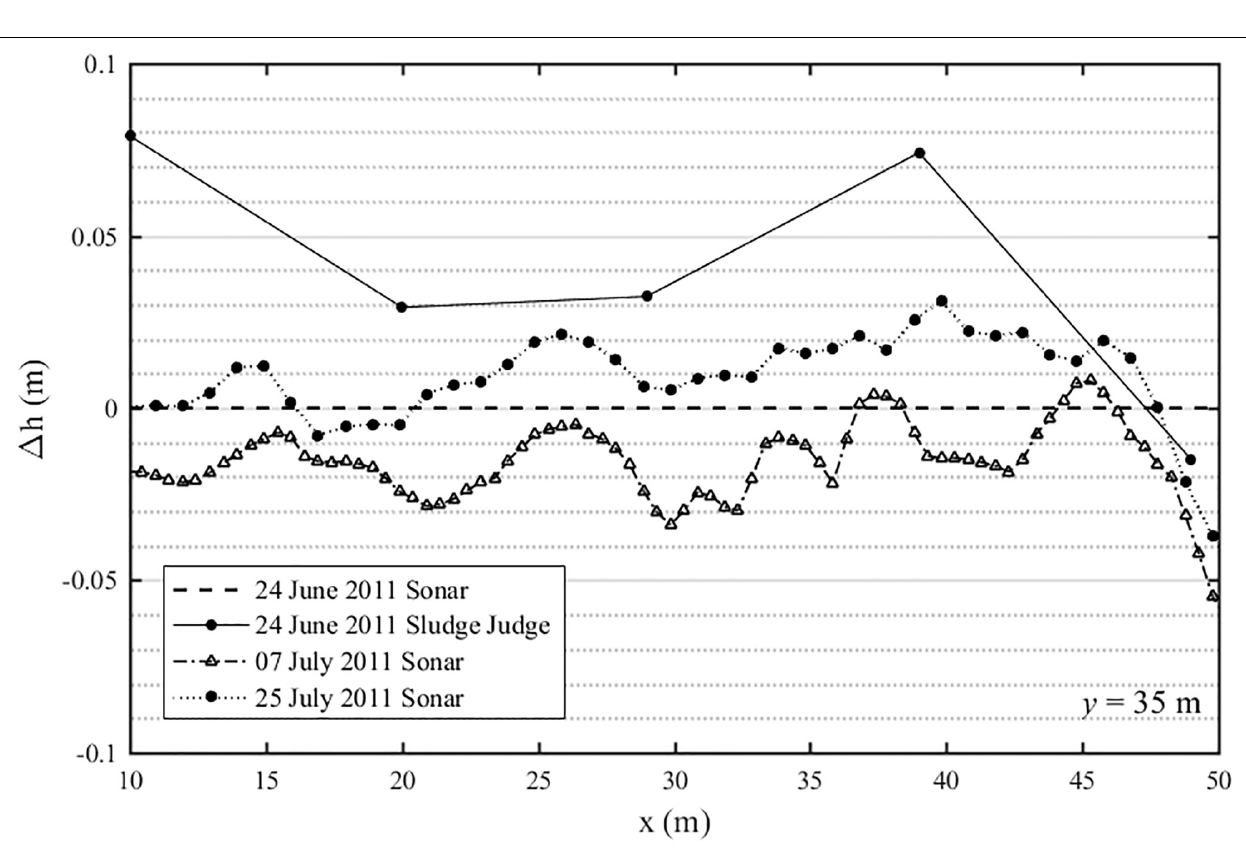
Frontiers in Earth Science |